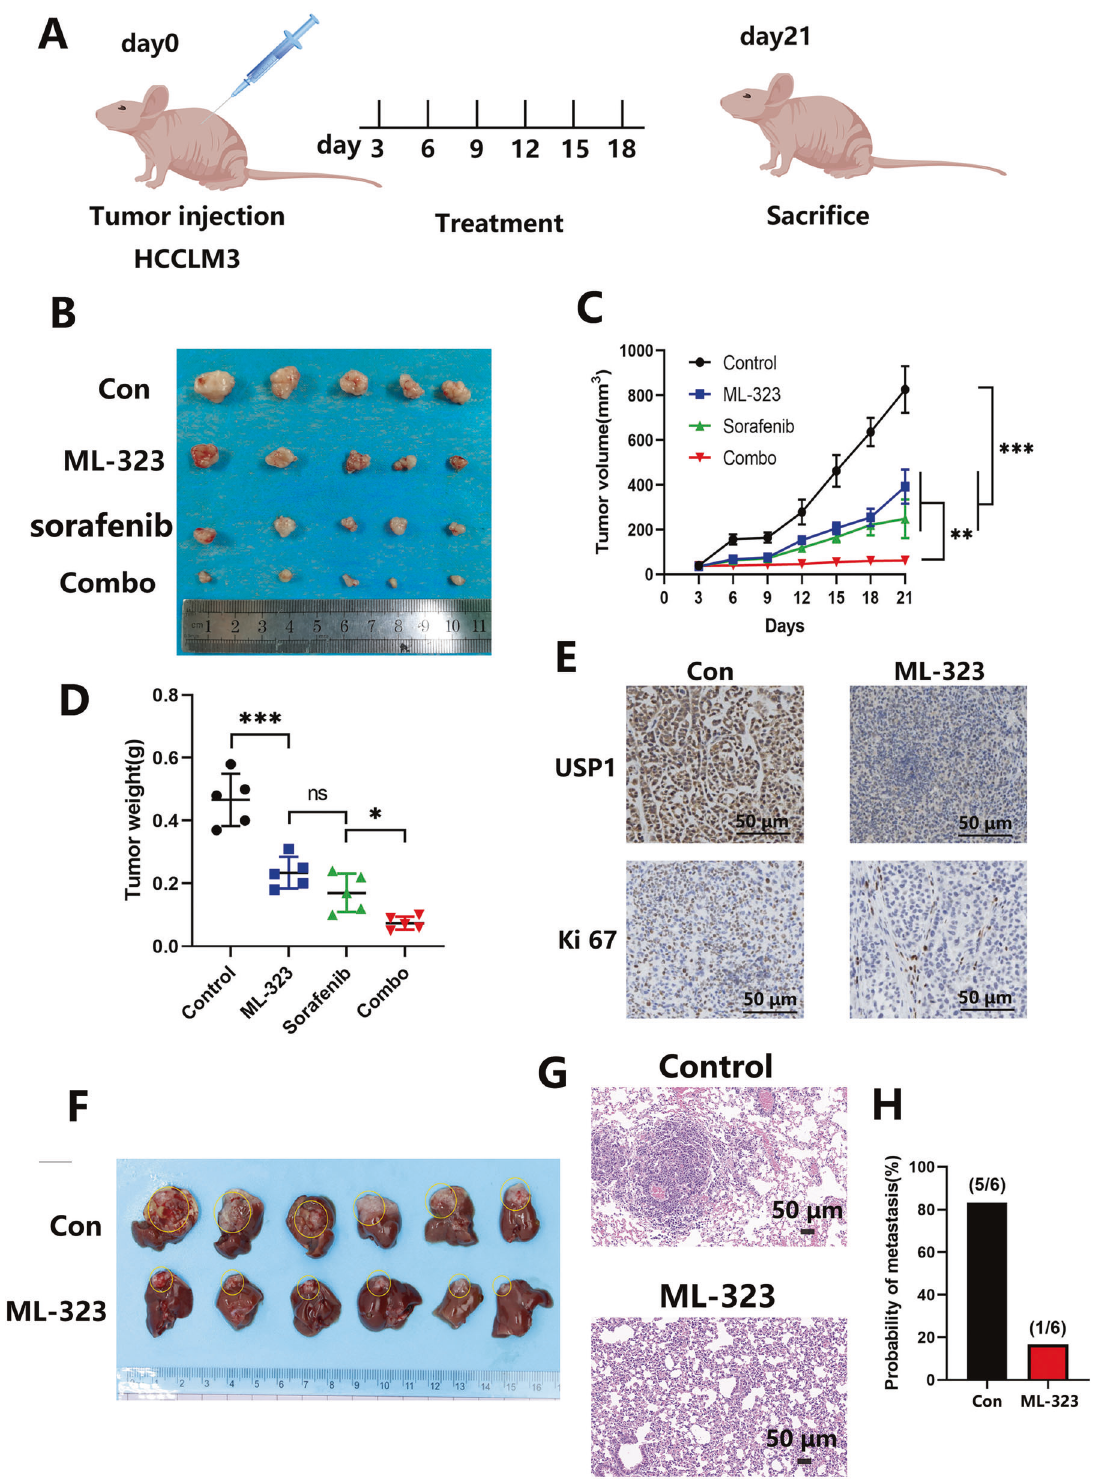
Fig. 8 ML-323 inhibits tumor growth and enhances the ef fi cacy of sorafenib in HCC mouse models. A Mice were implanted with HCC tumors and weighed starting the third day post-implantation. Tumor volume was measured in the groups once every three days. B ML-323 can enhance the therapeutic effect of sorafenib. HCCLM3 cells were grown into BALB/c-nu mice:(1)10%2-hydroxypropyl- β -cyclodextrin treated- mice, (2) ML-323-treated mice, (3) sorafenib-treated mice, and (4) ML-323 + sorafenib-treated mice. Tumor weights of the tumors in the four groups were recorded. C Tumor weights of the four groups. D Tumor volumes of four groups. E Immunohistochemical staining of tumor specimens. F HCCLM3 was inoculated into the orthotopic livers of nude mice and treated with ML-323 and 10%2-hydroxypropyl- β -cyclodextrin. G Hematoxylin and eosin (HE) staining of mouse lung tissue sections. H Lung metastasis of HCC in situ in mice treated with ML- 323 or 10%2-hydroxypropyl- β -cyclodextrin was analyzed. Scale bars = 50 μ m; * P < 0.05, ** P < 0.01, *** P < 0.001, signi fi cantly different compared to the control group. Cell Death and Disease (2022)